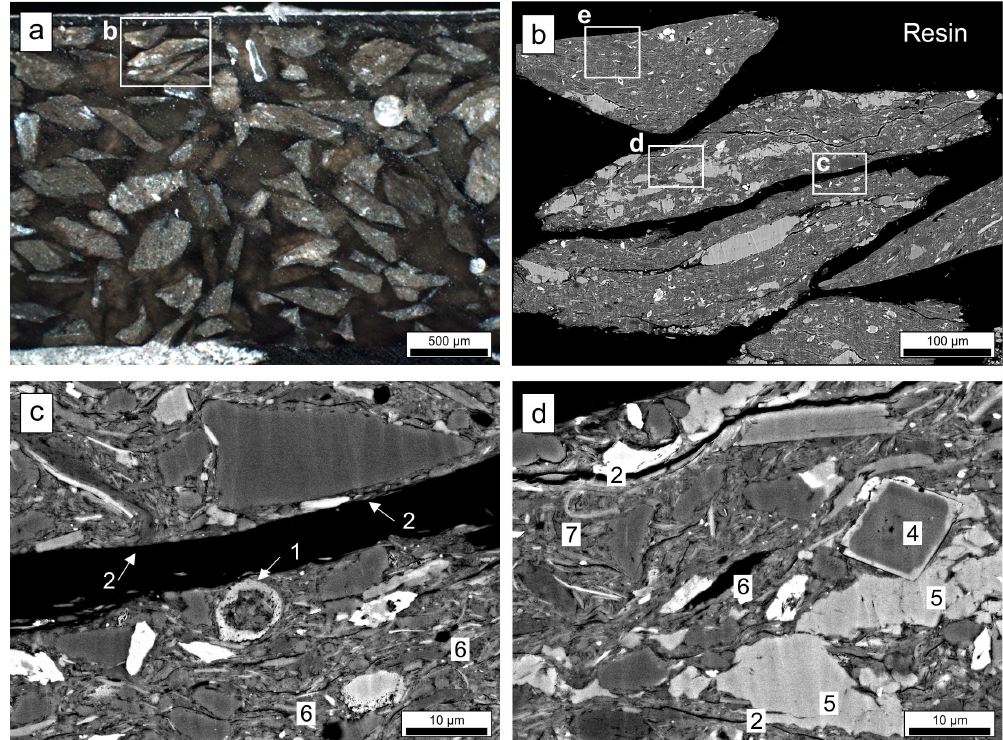
Figure 8. (a) shows resin-embedded microlithons in RLM. (b) – (d) are BIB-SEM micrograph insets of (a) . (b) shows fractured microlithons and calcite veins (bright). (c) is a detail of (b) showing a thin, microlithon bounding shear zone (2), an intact fossil (1) and unstrained OM (dark black, 6). (d) is a detail of (b) showing microlithon internal shear zones (2), calcite overgrowth (4), calcite veins (5), strained OM (6) and bending of clay particles (bright mica, 7). Detail (e) is shown in Fig.